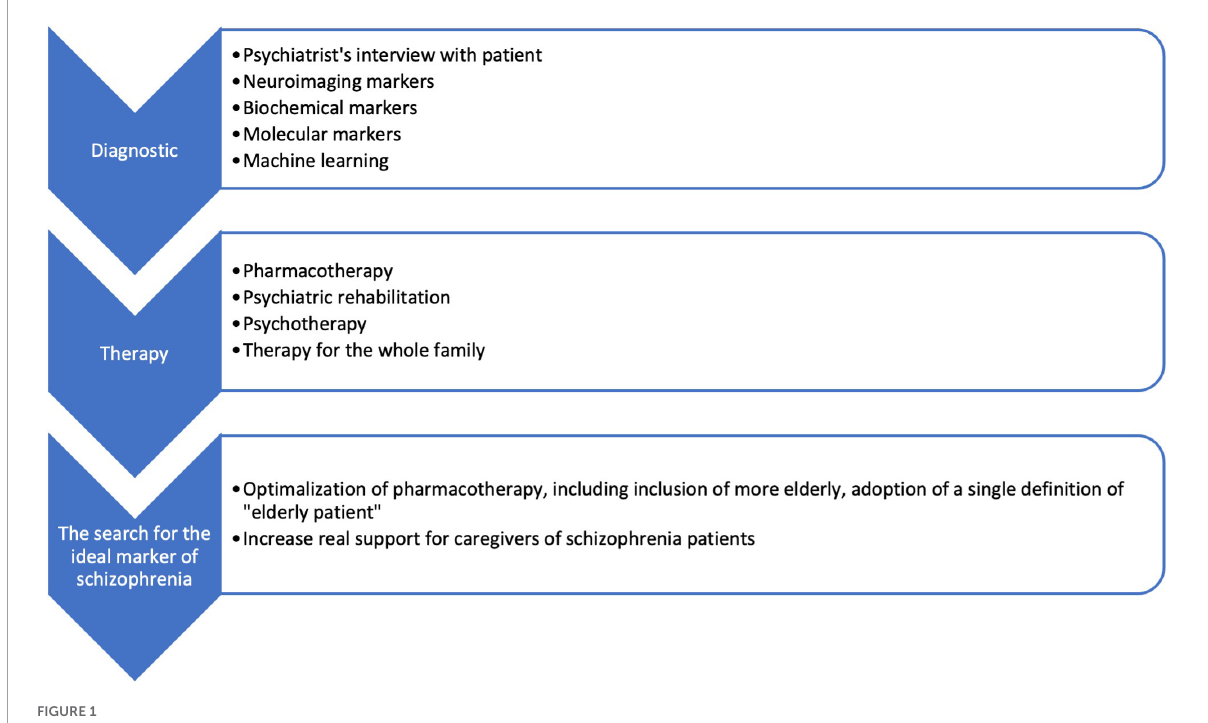
FIGURE1 Challenges in diagnosis, treatment of schizophrenia, and indicated next